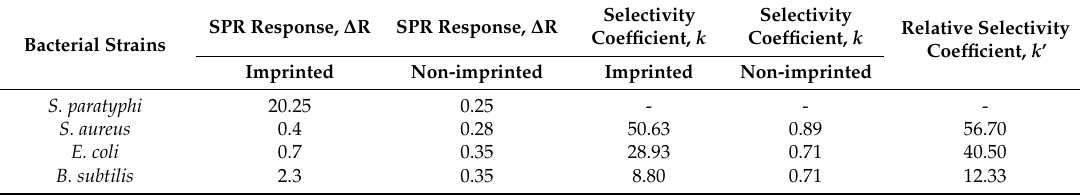
Figure 5. (A ) Selectivity of microcontact- S. paratyphi imprinted SPR biosensor against competing bacterial strains; Escherichia coli, Staphylococcus aureus, Bacillus subtilis , ( B ) Imprinting efficiency of the microcontact- S. paratyphi imprinted SPR chips vs. non-imprinted SPR chips, experimental conditions; sample concentration: 1.5 × 10 7 CFU/mL, flow rate: 200 µL/min, running buffer: PBS buffer, regeneration buffer: 10 mg/mL lysozyme solution, 50% ethyl alcohol. Table 1. Selectivity coefficients of S. paratyphi -MIP and NIP SPR chips ( Δ R: SPR response for the S. paratyphi -MIP and NIP SPR chips, k : selectivity coefficient for S. paratyphi versus competing bacterial strains, k ′ : relative selectivity coefficient for S. paratyphi -MIP SPR chips versus NIP SPR chips).